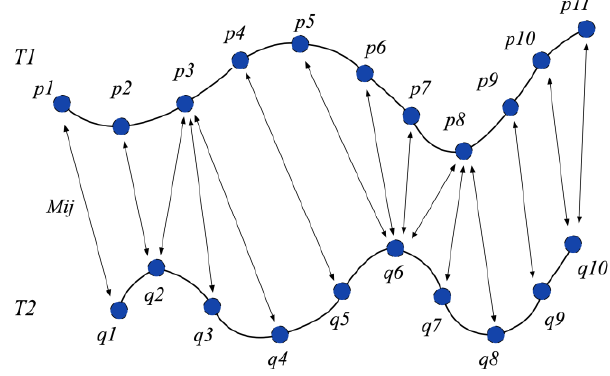
Figure 6. Trajectory point matching method in DTW algorithm.